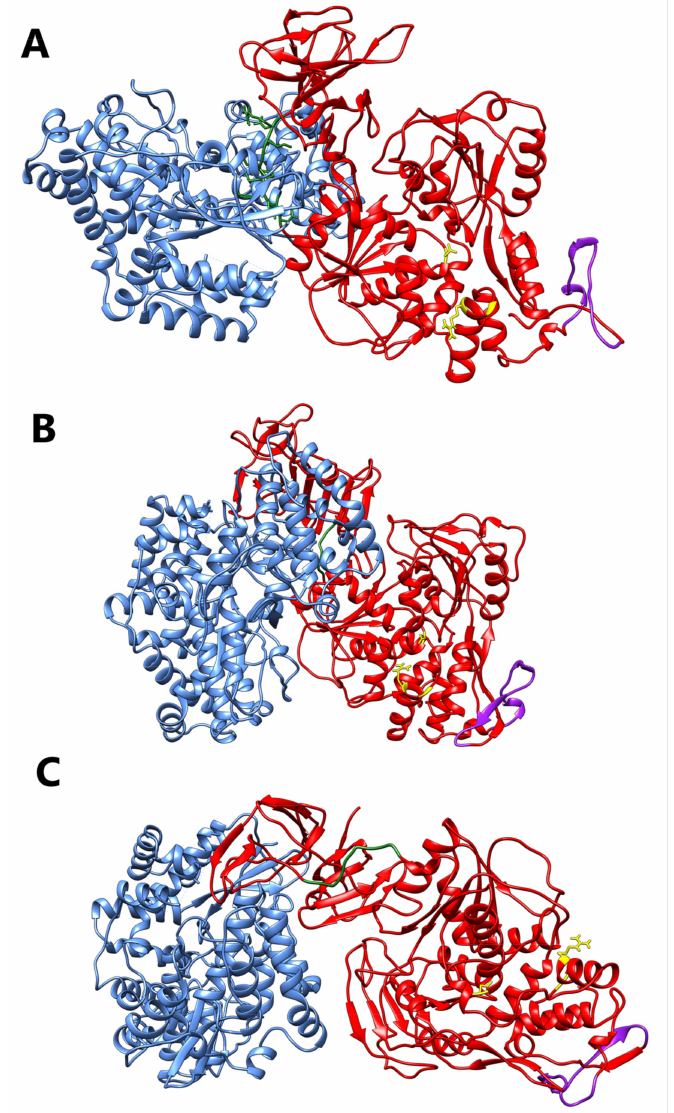
Figure A3. Docking of NS3 (red) to NS5 (blue). ( A ) wild type (WT), ( B ) phosphorylated at S137, ( C ) phosphorylated at T189. The NS3 residues 566–585 are shown in purple. The linker region residues 169–179 ae shown in green. The residues shown in yellow are residue numbers S137, A164, and Q167 to allow comparison of the